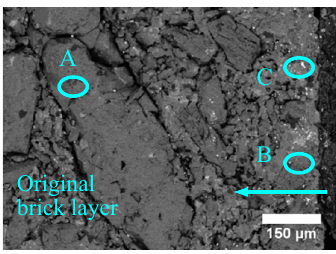
Figure 8: SEM picture of cross section at 1/2 height of MgO · Al 2 O 3